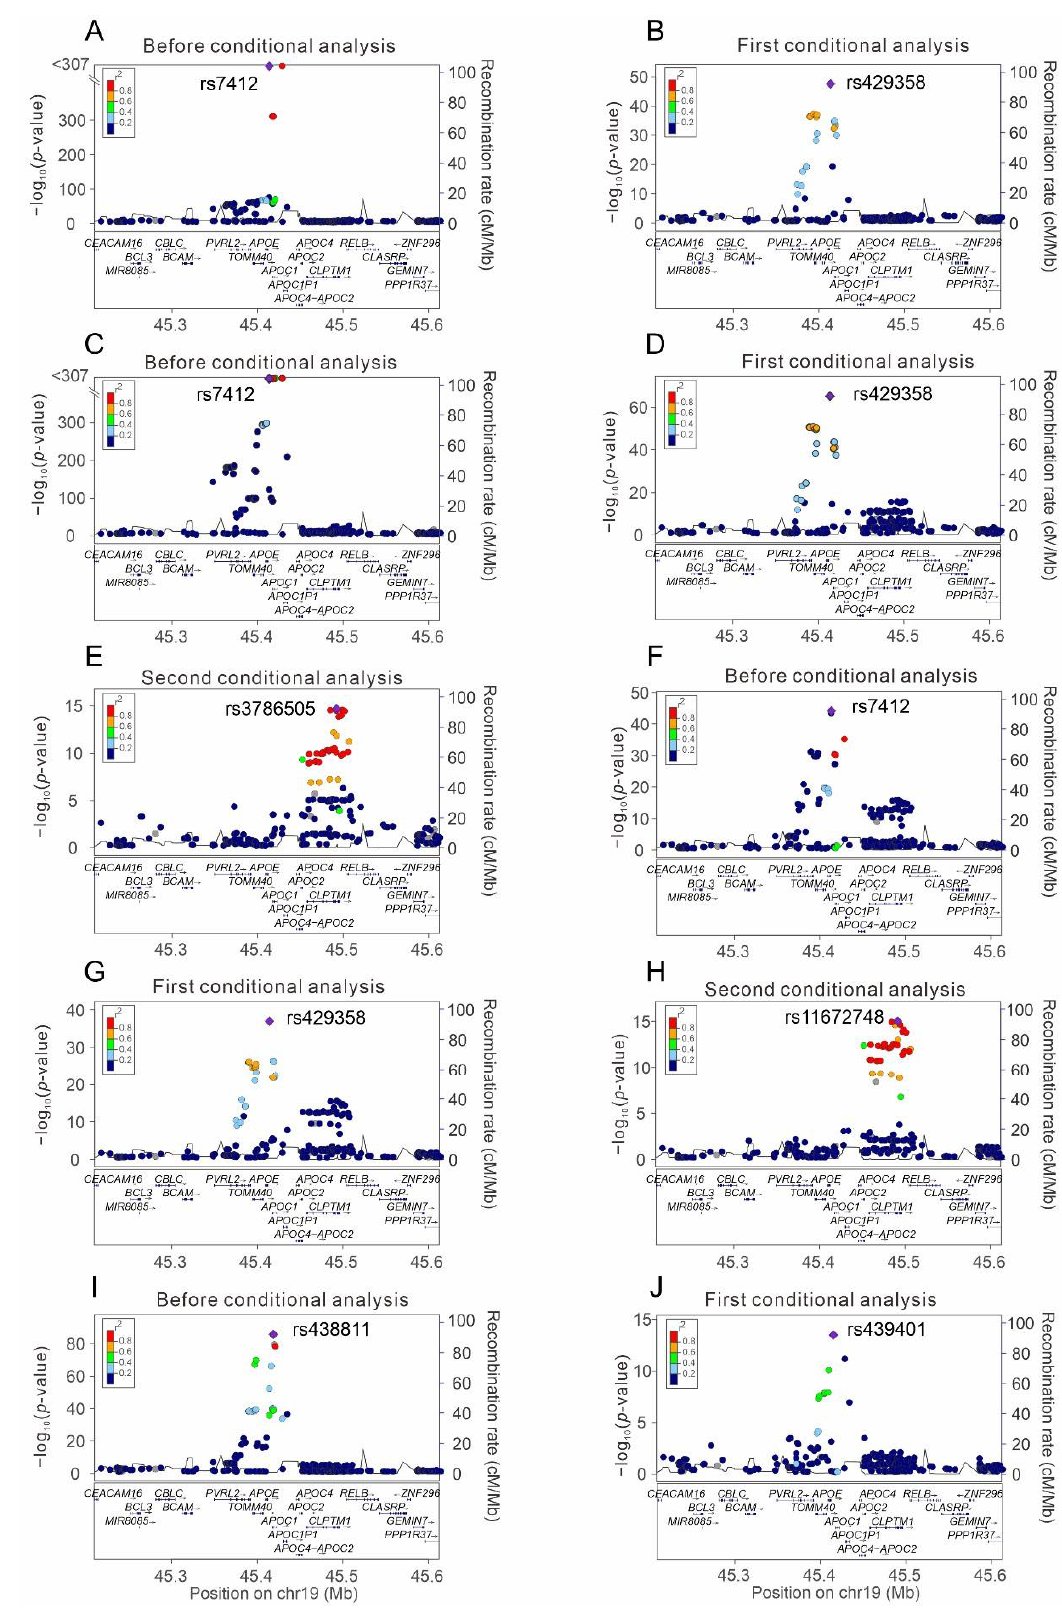
Figure 2. Regional association analysis for genetic variants around the APOE gene region and serum lipid levels. ( A , B ) For total cholesterol levels, ( C – E ) for LDL cholesterol levels, ( F – H ) for HDL cholesterol levels, and ( I , J ) for triglyceride levels.